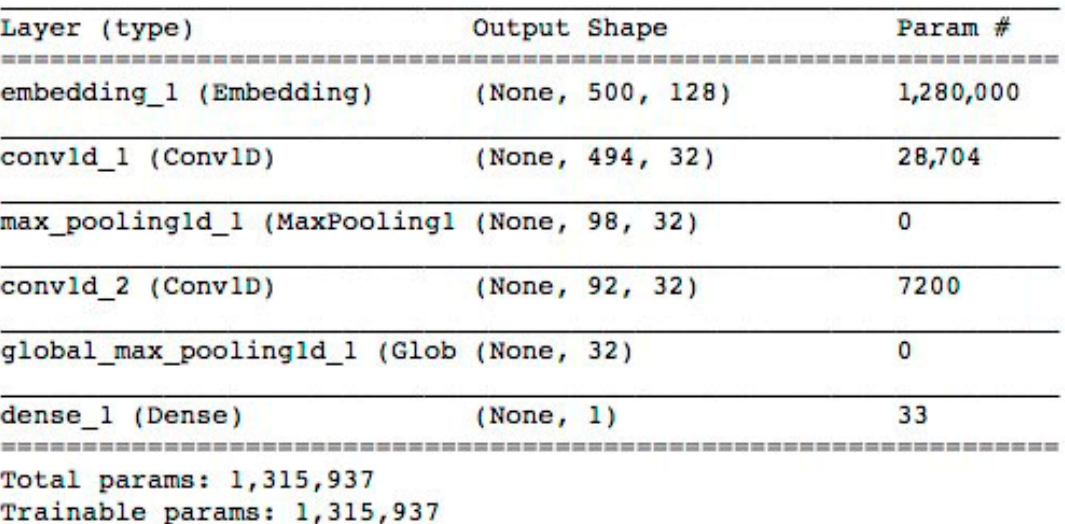
Figure 6. Structure diagram of convolutional neural network.